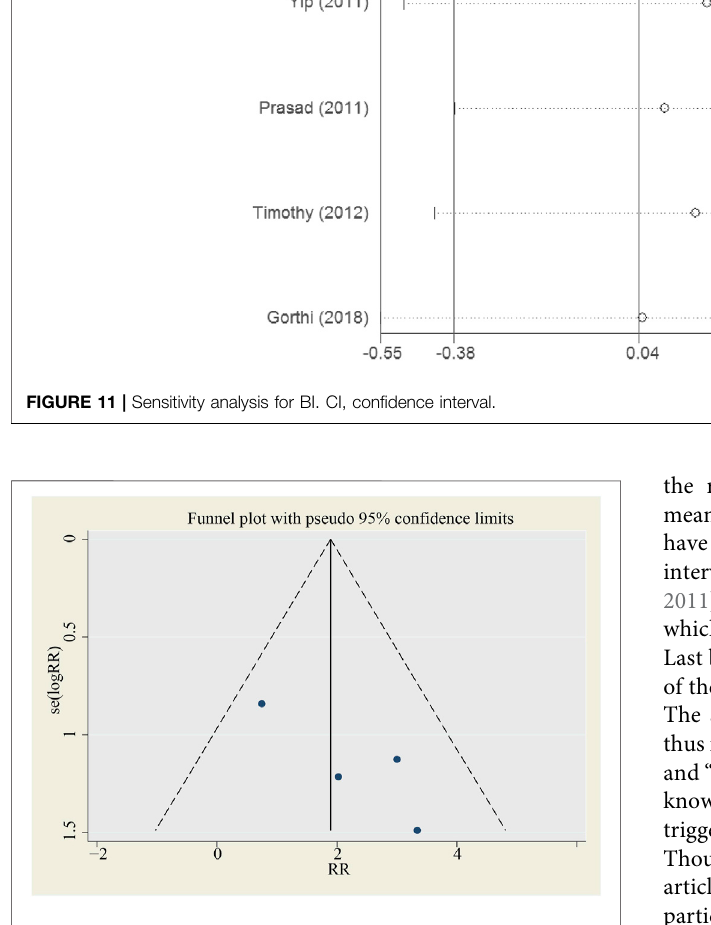
Frontiers in Pharmacology |